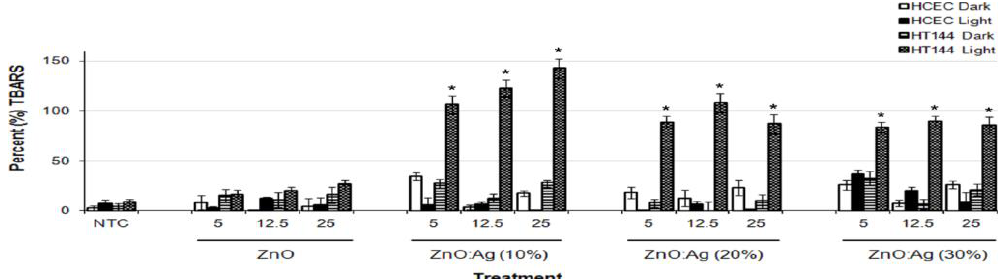
Figure 36. Thiobarbituric acid reactive substances (TBARS) assay results for HCEC and HT 144 cells treated with ZnO, ZnO:Ag(10%), ZnO:Ag(20%) and ZnO:Ag(30%) of different concentrations (5, 12.5 and 25 µ g / mL). Data are expressed as percent (%) TBARS (mean ± SD). * p < 0.0001 (two tailed t -test) when compared to HCEC dark, HCEC light and HT144 dark. Reproduced from [175] under the terms of the Creative Commons Attribution